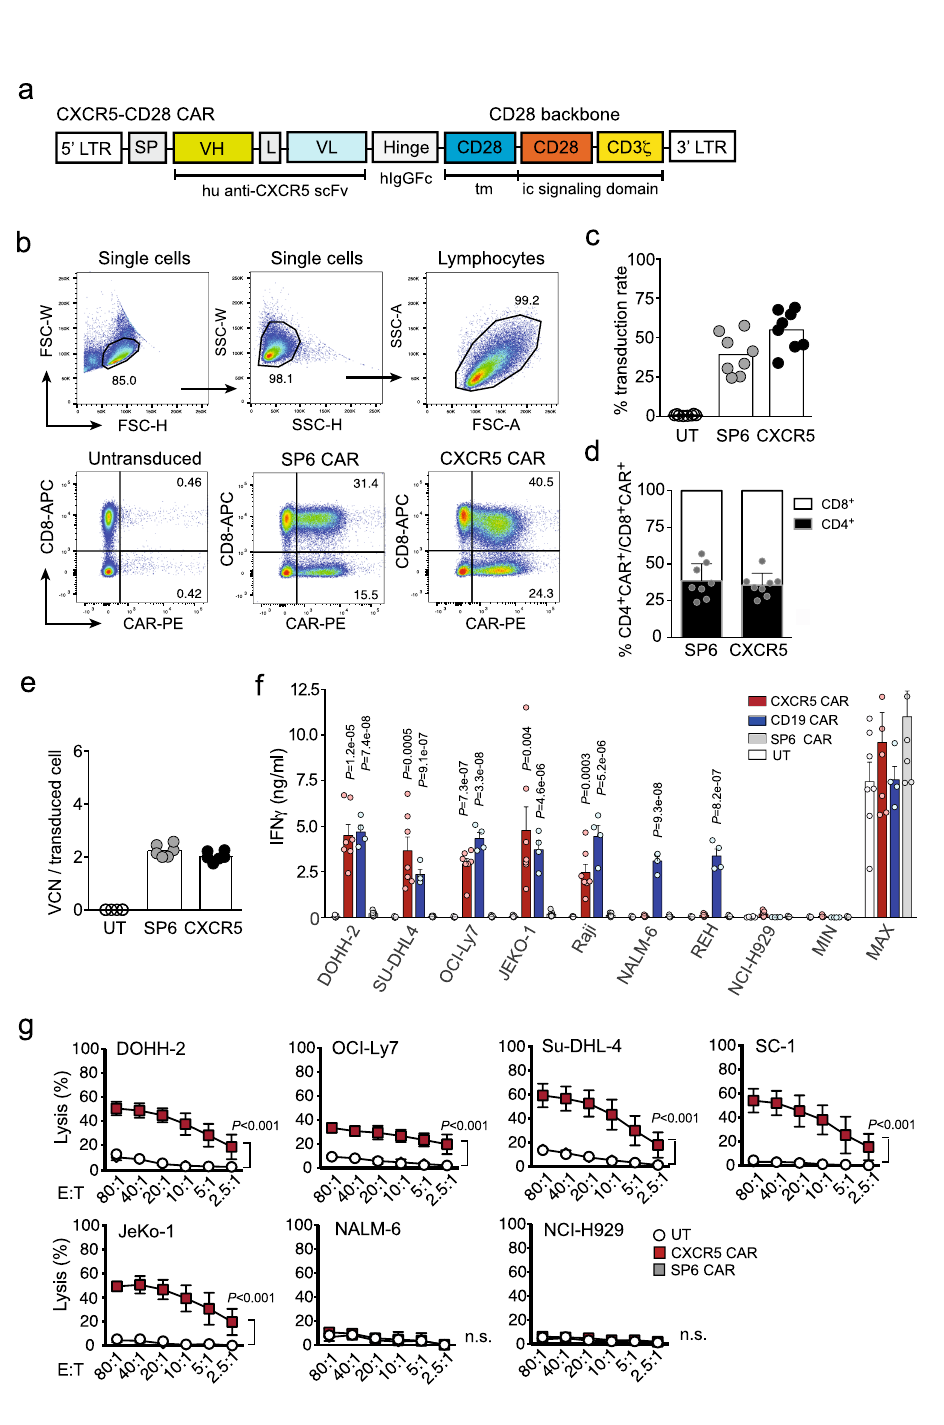
Fig. 1 CXCR5 is strongly expressed on mature B-NHL cell lines and primary B-NHL cells. Surface expression of CXCR5 was analyzed by fl ow cytometry and the number of CXCR5 molecules per cell was determined for tumor cell lines ( a , b ), patient-derived primary B-NHL cells ( c , d ) and for peripheral blood lymphocytes ( e ). Representative data ( a ; CXCR5, black line; isotype control, fi lled curve) and pooled data ( b ) from independent measurements of the following tumor cell lines: B-NHL (FL: DOHH-2 n = 8, SC-1 n = 4; DLBCL: SU-DHL4 n = 4, OCI-Ly7 n = 6; MCL: JeKo-1 n = 3), B-ALL (NALM-6 n = 3, REH n = 4), MM (NCI-H929 n = 3), T-ALL (Jurkat n = 2) and controls (HEK n = 1, HEK-CXCR5 n = 1). CXCR5 surface expression ( c ; CXCR5, black line; isotype control, fi lled curve) and density per cell ( d ) of 25 patient-derived primary B-NHL cells (FL n = 7: #252, #457, #563, #1054, #85, #1100, and #1129; CLL n = 8: #819, #821, #890, #12, #31, #33, #47 and #75; MCL n = 6: #777, #545, #114, #578, #624, and #988; MZL n = 4: #728, #769, #421, and #441). The gating strategies are shown in Supplementary Figs. 1a – d, 2a – d. e CXCR5 density per cell for peripheral blood lymphocyte subpopulations of n = 5 healthy individual donors. b , d , e Individual values and means as bars. Source data are provided as a Source Data fi